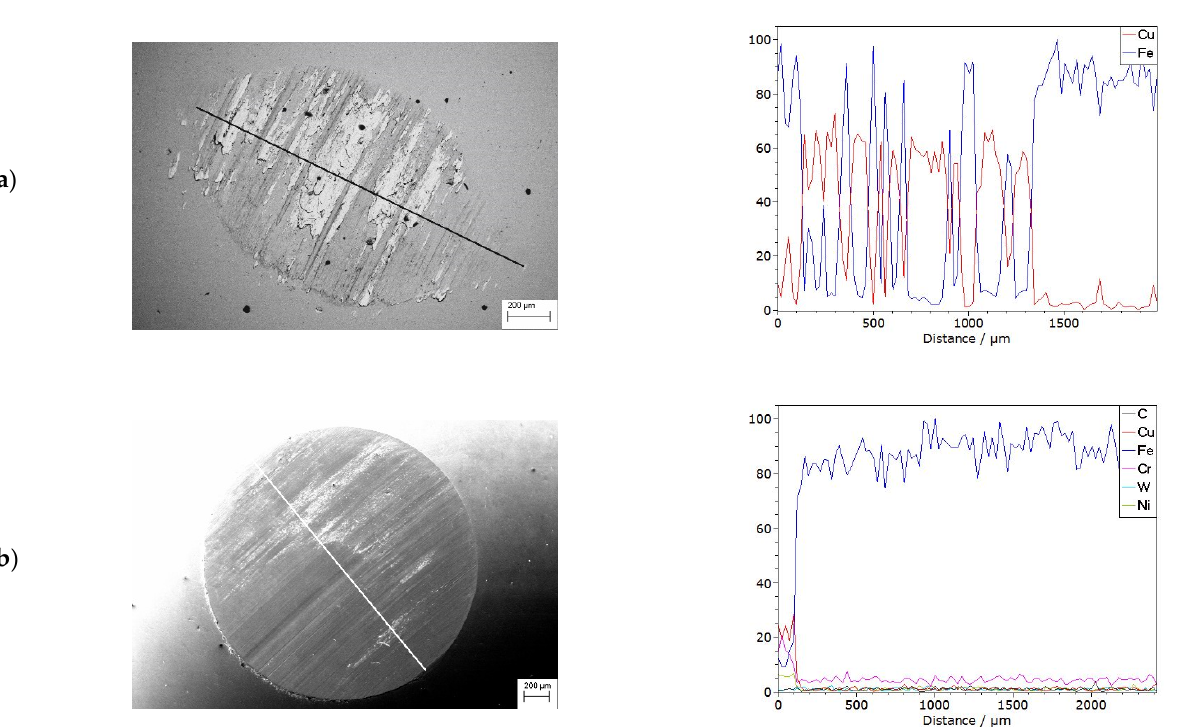
Figure 19. A trace of abrasion of a steel ball after a friction test and linear analysis of changes in chemical composition of ( a ) copper and ( b ) copper with laser alloying Cr–WC particles.